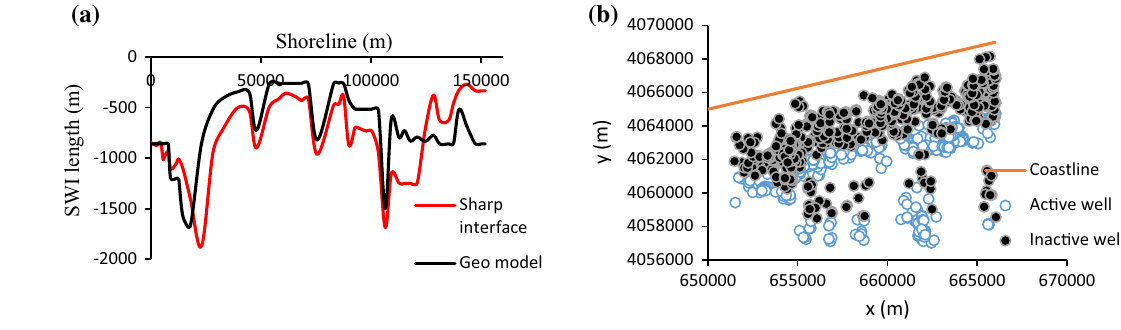
Fig. 11 a Saltwater toe location parallel to shoreline for analytical and geo model, b pumping wells distribution parallel to shoreline